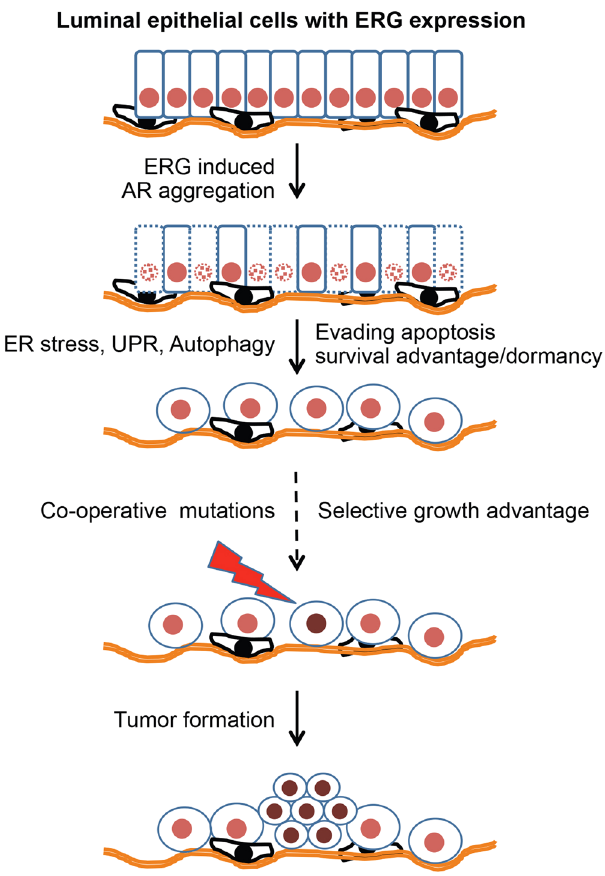
Figure 10. Model depicting ERG-induced AR aggregation as one of the key molecular pathways towards malignant transformation of prostate luminal epithelial cells. Significant numbers of differentiated luminal epithelial cells initially undergo apoptosis due to transgenic expression of ERG and later gain a survival advantage. During this transition, several proteins involved in ER stress and autophagy pathways were up-regulated in luminal epithelial cells. These cells potentially serve as targets for subsequent genetic alterations that confer proliferative